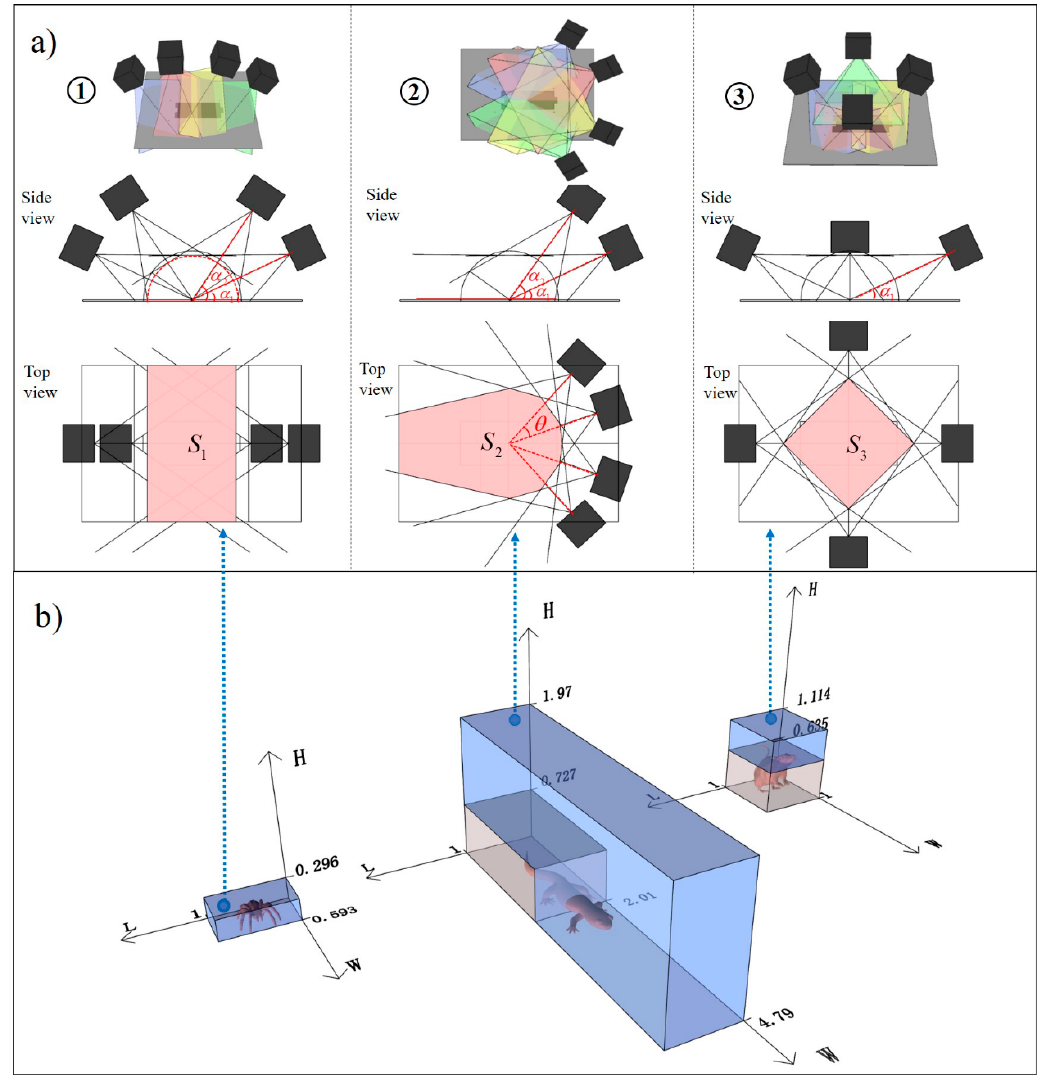
Figure 3. ( a ) Projections of three typical camera layouts and their field of view intersection areas in the horizontal and vertical planes; ( b ) Volumetric representations of the intersections of three typical camera layouts in the field of view are the simplest cubic representations (in units of length L ), the width W and the height H are proportional to the long L , respectively) and their shape matching with the typical capture object.